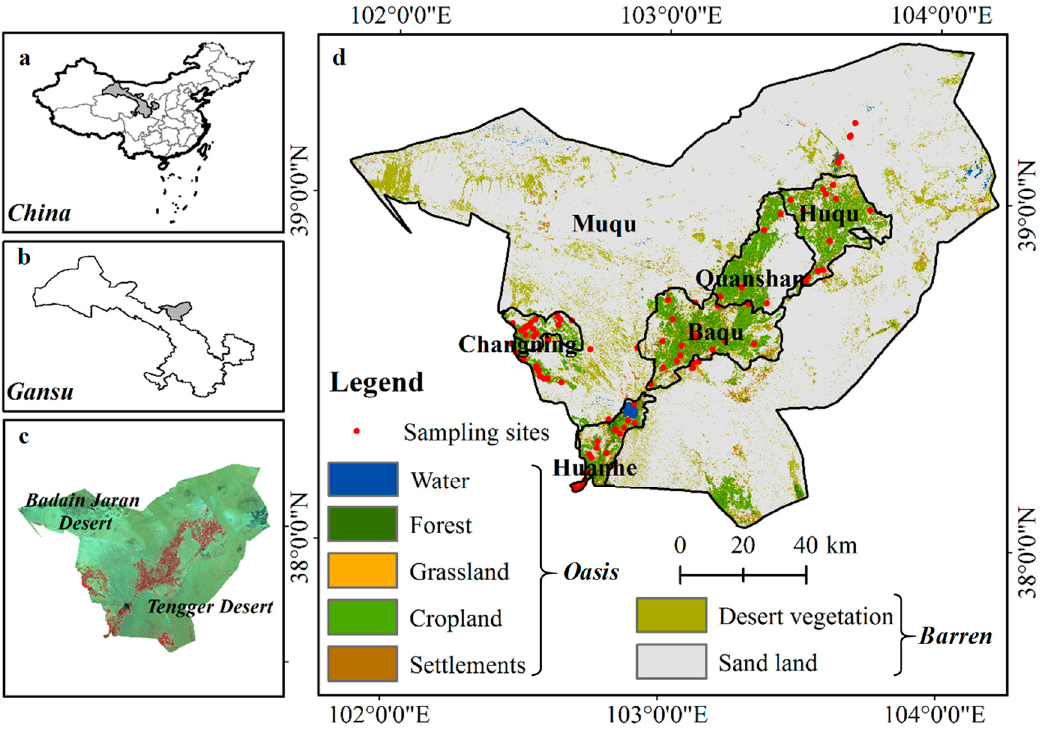
Figure 1. Study area and soil sampling points. ( a , b ) location of Minqin in Gansu Province, Northwest China. ( c ) false-color composites of GF-1 WFV bands 4, 3, and 2 (Red, Green and Blue, respectively) on 30 August 2015, in the study area. ( d ) soil sampling plots distributed in six districts and the compound dryland landscapes of the study area.